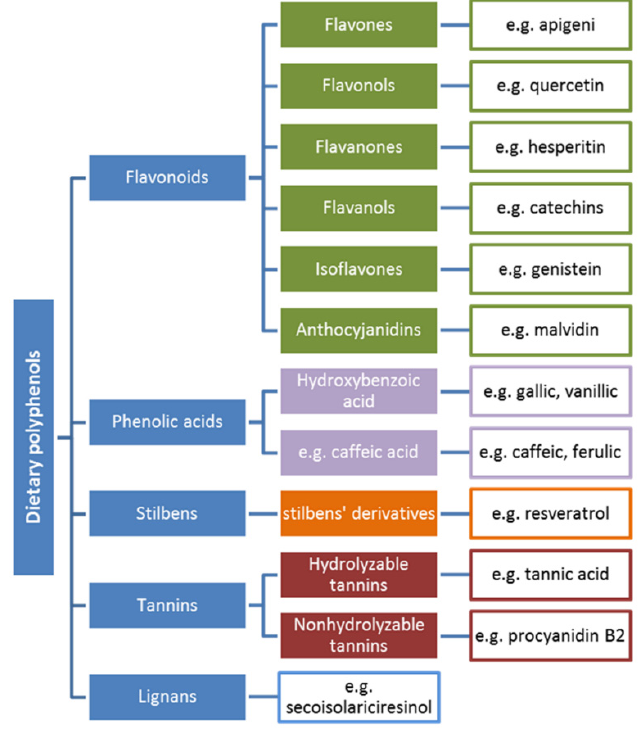
Figure 1. Dietary polyphenols—classification and examples [54].